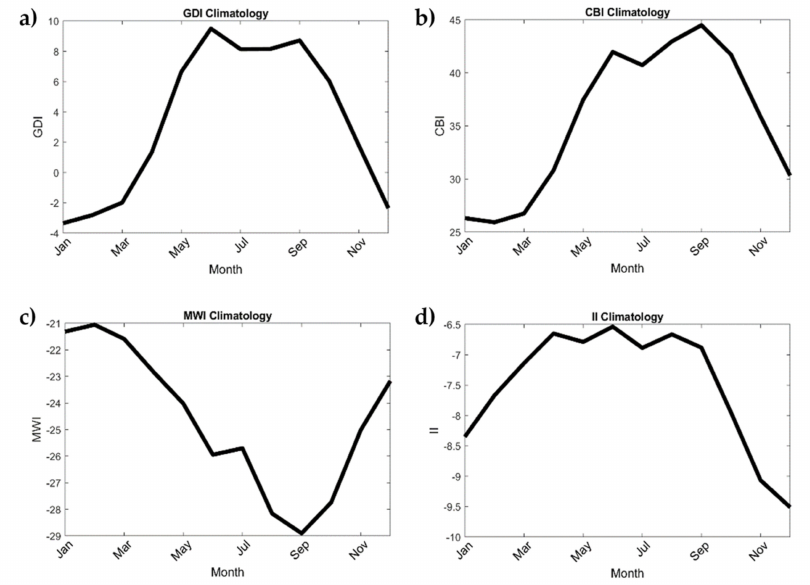
Figure 6. Galvez-Davidson Index (GDI) and sub-index annual climatology results for the ( a ) the GDI, ( b ) Column Buoyancy Index (CBI), ( c ) the Mid-level Warming Index (MWI), and ( d ) the Inversion Index (II) for the Caribbean and surrounding region (5 ◦ –31 ◦ N, 100 ◦ W–55 ◦ W) for base period 1982–2020.